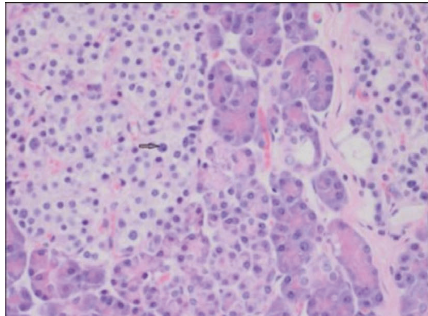
Figure 2: Islet cells at 200 × magnification, with arrow indicating an enlarged